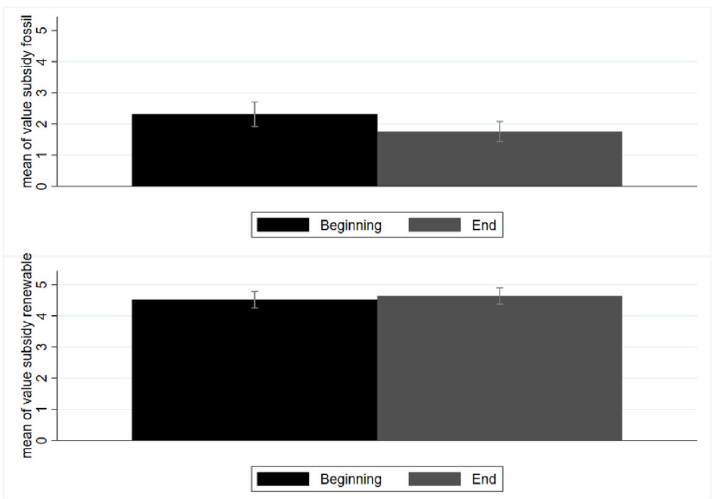
Figure 5. Average values assigned to subsidies for the self-consumption of energy from fossil and renewable sources. Black bars represent the average values at the beginning of the course and grey bars represent the average values at the end of the course. All values are expressed in